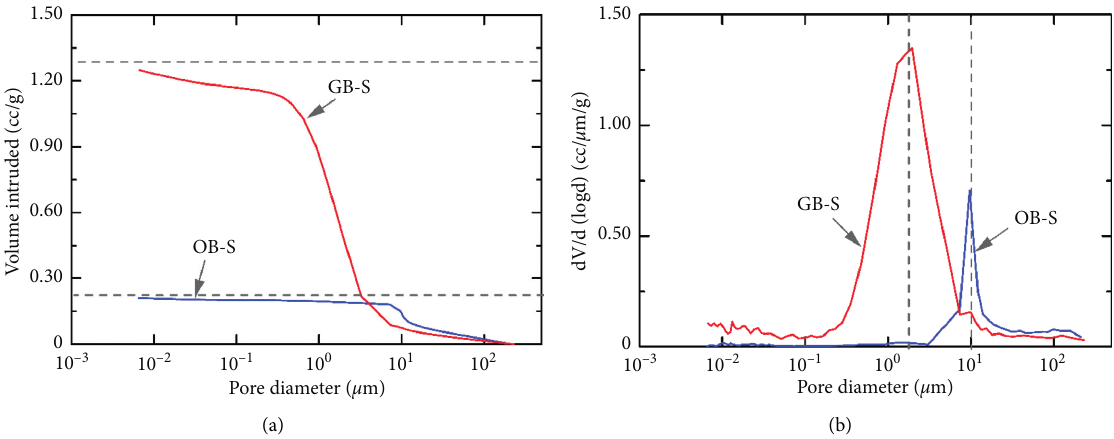
Figure 11: PSD of original and granular bentonites at pasty state by MIP. (a) Cumulative pore volume and (b) PSD